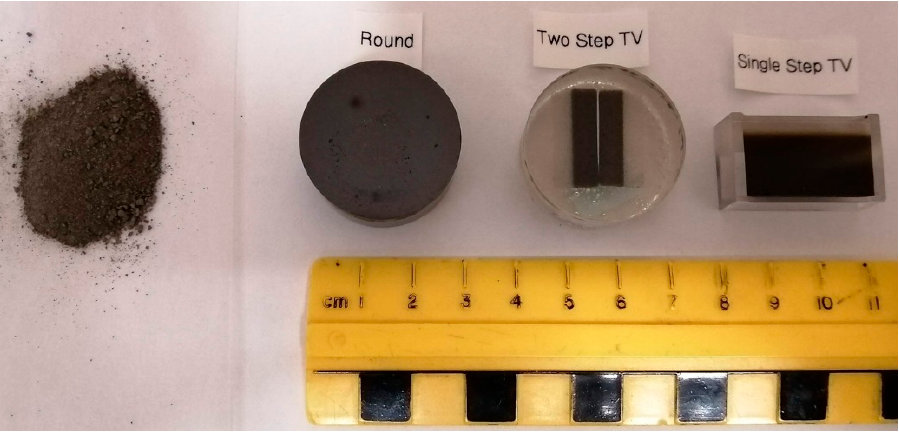
Figure 1. Raw sample material alongside the three cast methods.